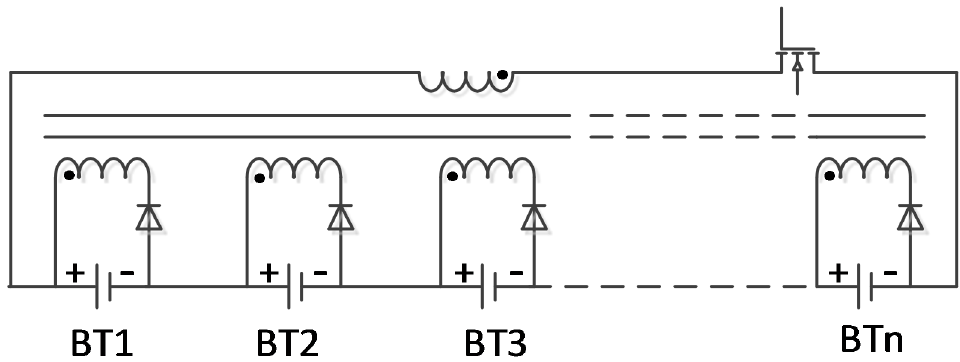
Figure 5. Principle of multi-winding transformer balance.